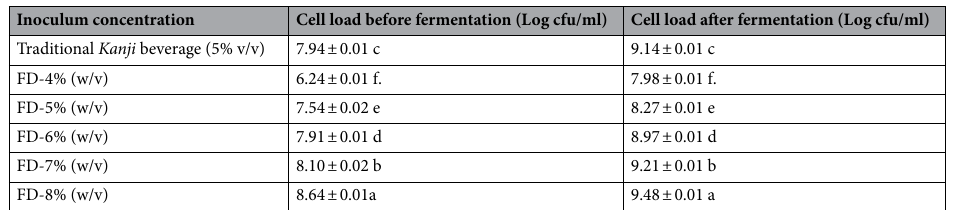
Table 3. Functional freeze-dried LAB inoculum concentration optimization for Kanji beverage fermentation. FD- freeze-dried inoculum concentration, mean ± standard deviation, similar letters have no significant effect.